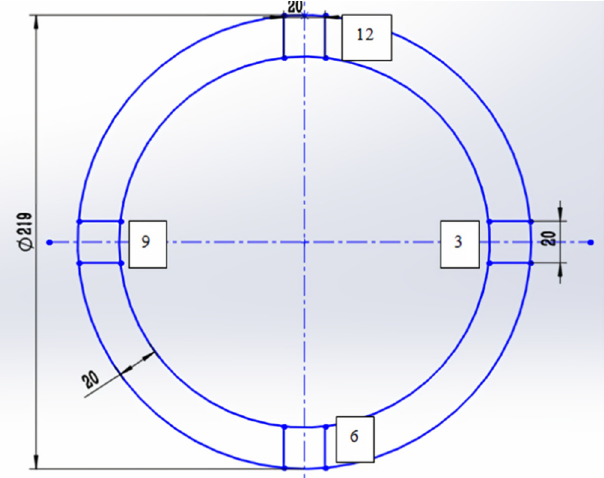
Figure 3. Schematic diagram of metallographic sampling position.